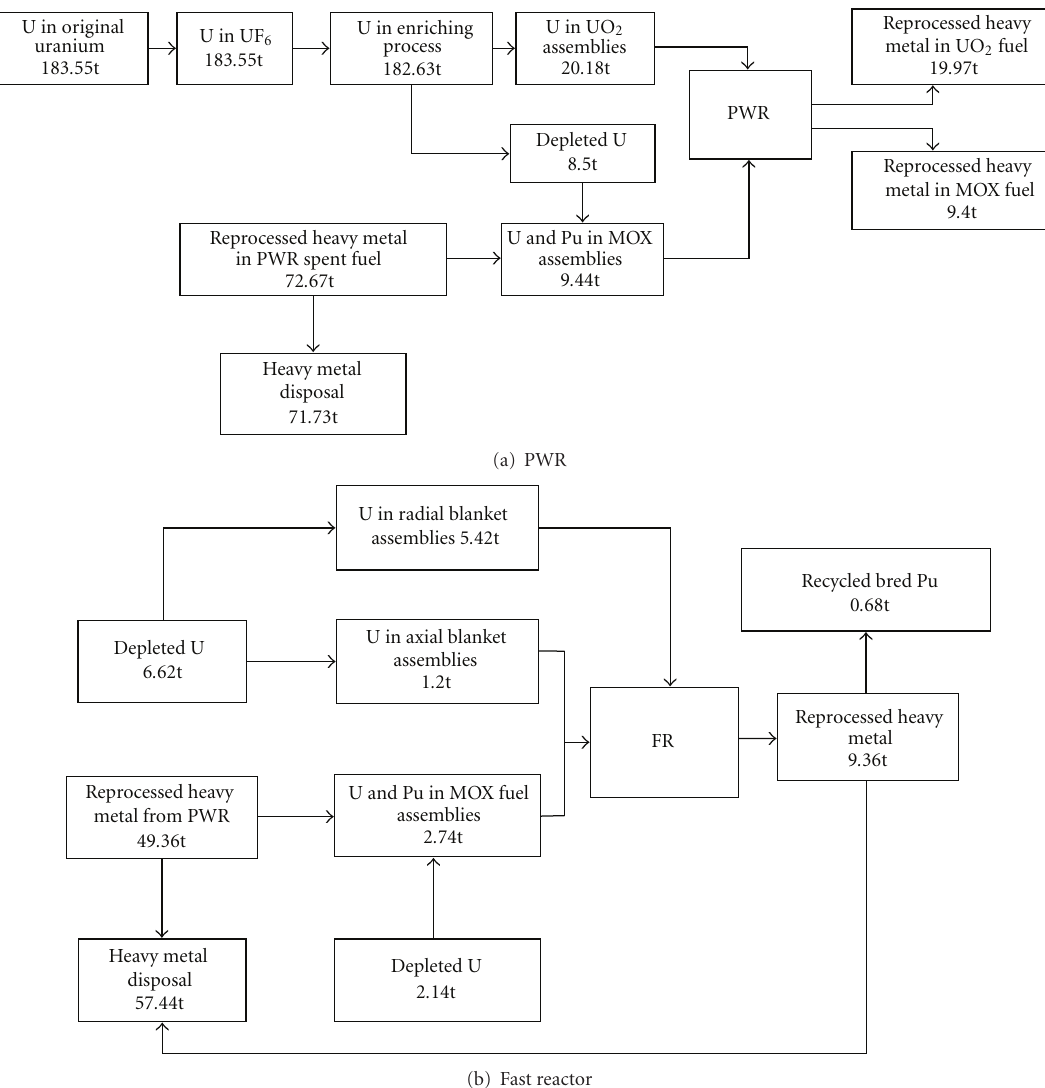
Figure 6: The mass balance of heavy metal in the closed fuel